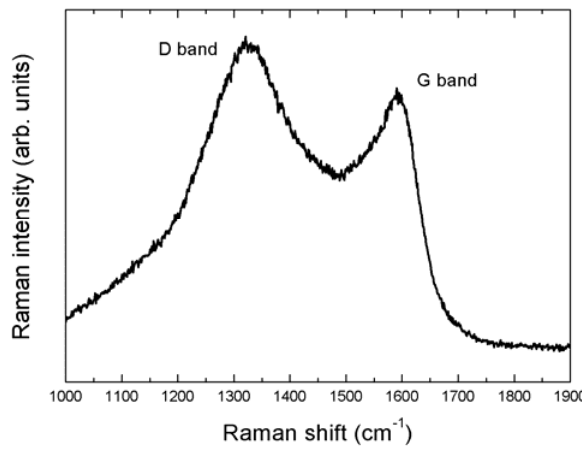
Figure 3. Raman spectrum of the activated carbon.